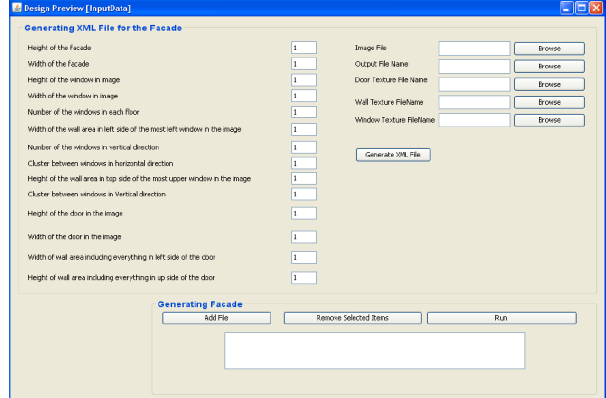
Figure 7. Interface of the application Dynamic Pulse Function